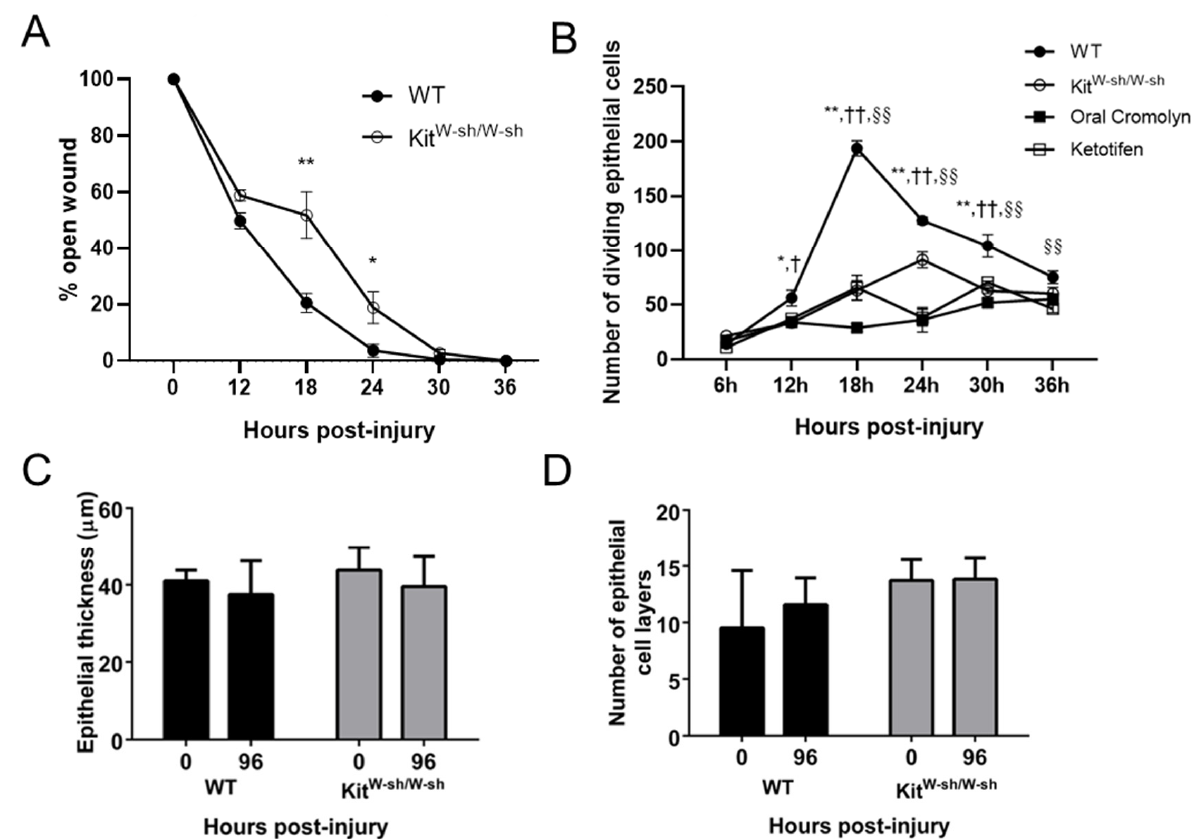
Figure 5. Changes in epithelial healing after corneal abrasion in Kit W-sh/W-sh mice and WT mice treated with mast cell stabilizers. ( A ) The rate of epithelial wound closure was determined by fluorescein dye retention and expressed as a percent of the initial wound area. ( n = 6 per group, * p ≤ 0.05, ** p ≤ 0.01). ( B ) Numbers of dividing basal epithelial cells were determined at different times after corneal abrasion. ( n = 6 per group, * p ≤ 0.05, ** p ≤ 0.01 compared to Kit W-sh/W-sh ; n = 6 per group, † p ≤ 0.05 and †† p ≤ 0.01 compared to oral cromolyn; n = 6 per group, §§ p ≤ 0.01 compared to ketotifen). ( C ) Epithelial thickness and ( D ) numbers of epithelial cell layers were determined from transverse histological sections of the cornea before injury (time 0) and 96 h post-abrasion.